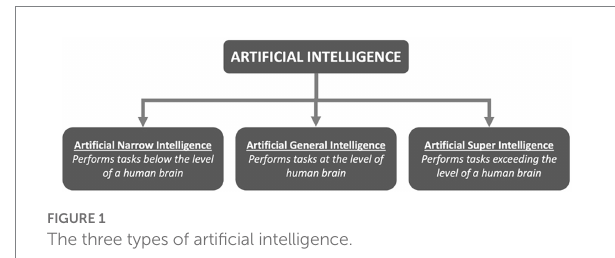
FIGURE 1 The three types of artificial